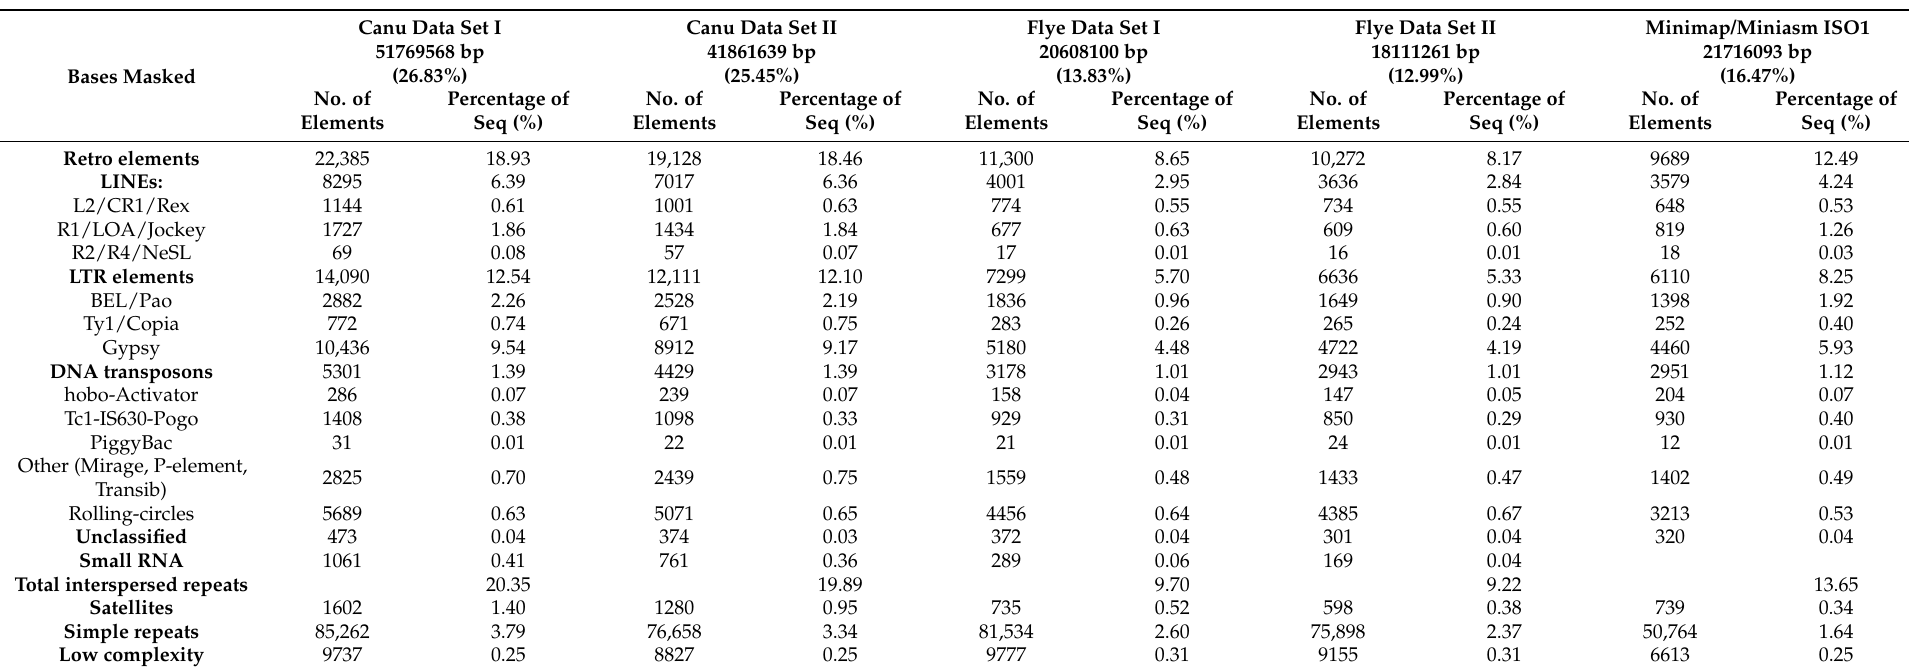
Table 4. A general analysis of the repetitive sequences performed with RepeatMasker on Canu and Flye assemblies of Horezu strain versus minimap/miniasm—ISO1 (adapted from RepeatMasker